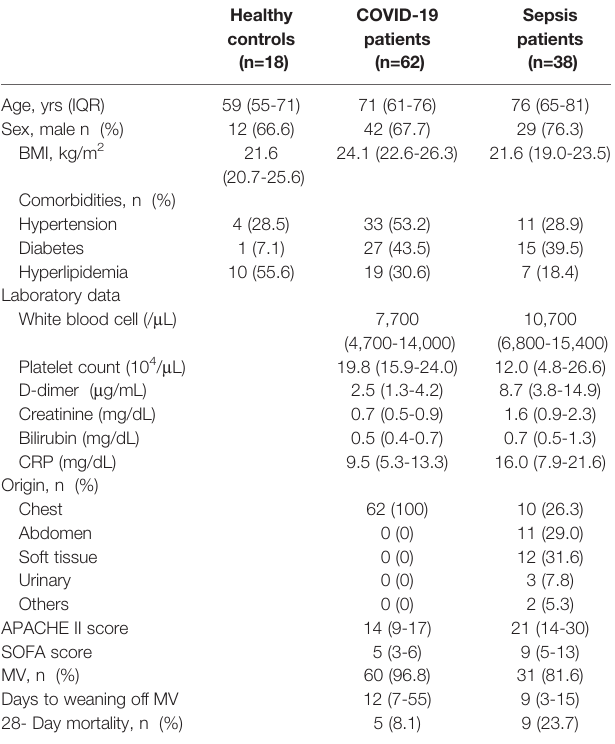
TABLE 2 | Clinical and Demographic Characteristics of COVID-19 and Sepsis Patients in the Osaka Cohort 2. Healthy controls